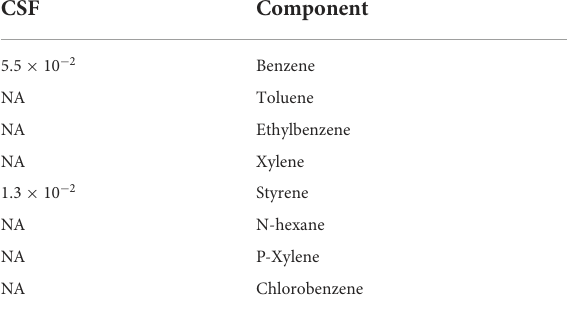
TABLE 4 The cancer slope factors for VOCs.